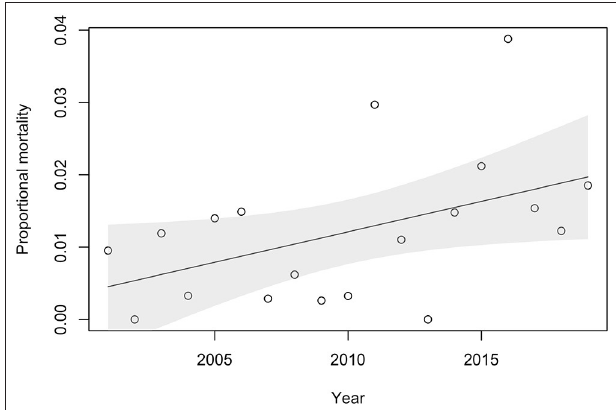
FIGURE 2 | Proportional P. tenuis- induced mortality by year based on necropsies performed by the University of Minnesota Veterinary Diagnostic Laboratory between January 2001 and December 2019 on sheep, llamas, goats and alpacas. The solid line is the positive trend over time and the gray shaded area represents the 95% confidence interval. Data represent the number of positive P. tenuis necropsy cases out of the total number of necropsy cases for these species examined in the time period.